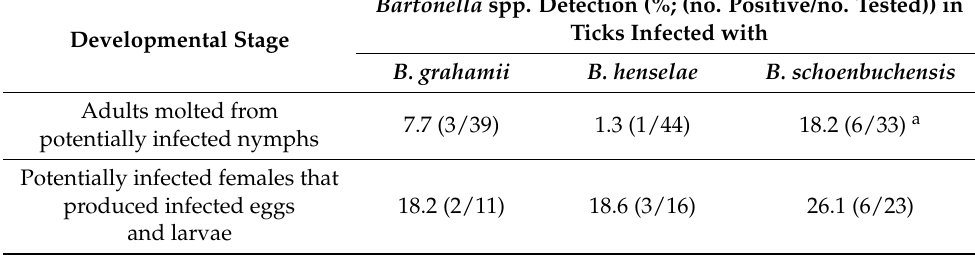
Table 4. Transmission success of Bartonella species between tick life stages. Bartonella spp. Detection (%; (no. Positive/no. Tested)) in Ticks Infected Developmental Stage